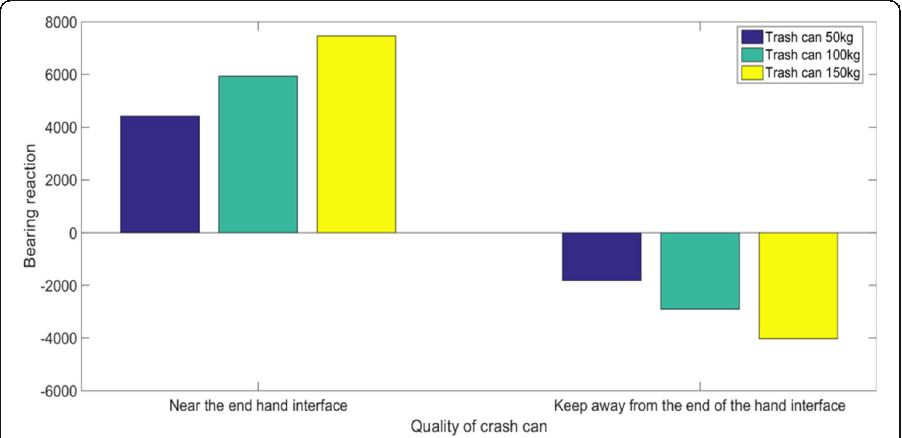
Fig. 6 Comparison of front and rear reaction forces at the gripper interface of the